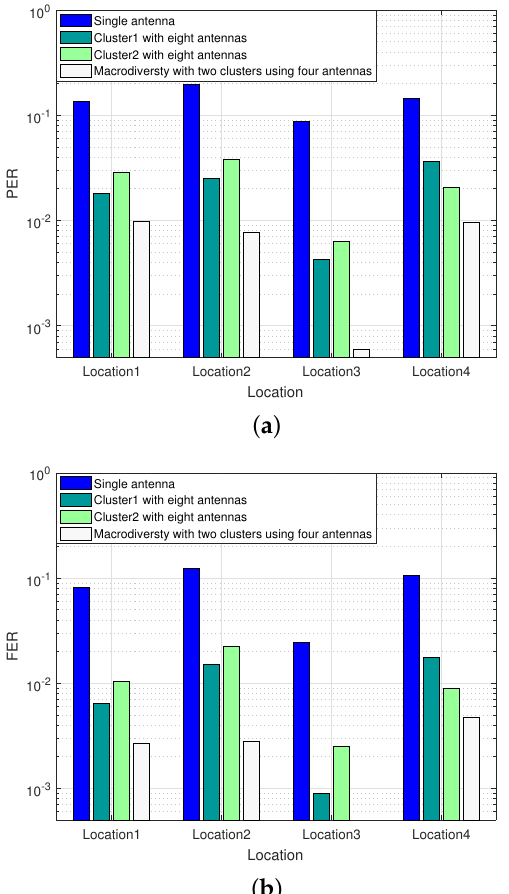
Figure 14. Performance comparison of diversity scheme with different antenna configuration schemes. ( a ) Comparison of PER between macrodiversity reception scheme with two clusters using four antennas and single cluster using eight antennas reception scheme. ( b ) Comparison of FER between macrodiversity reception scheme with two clusters using four antennas and single cluster using eight antennas reception